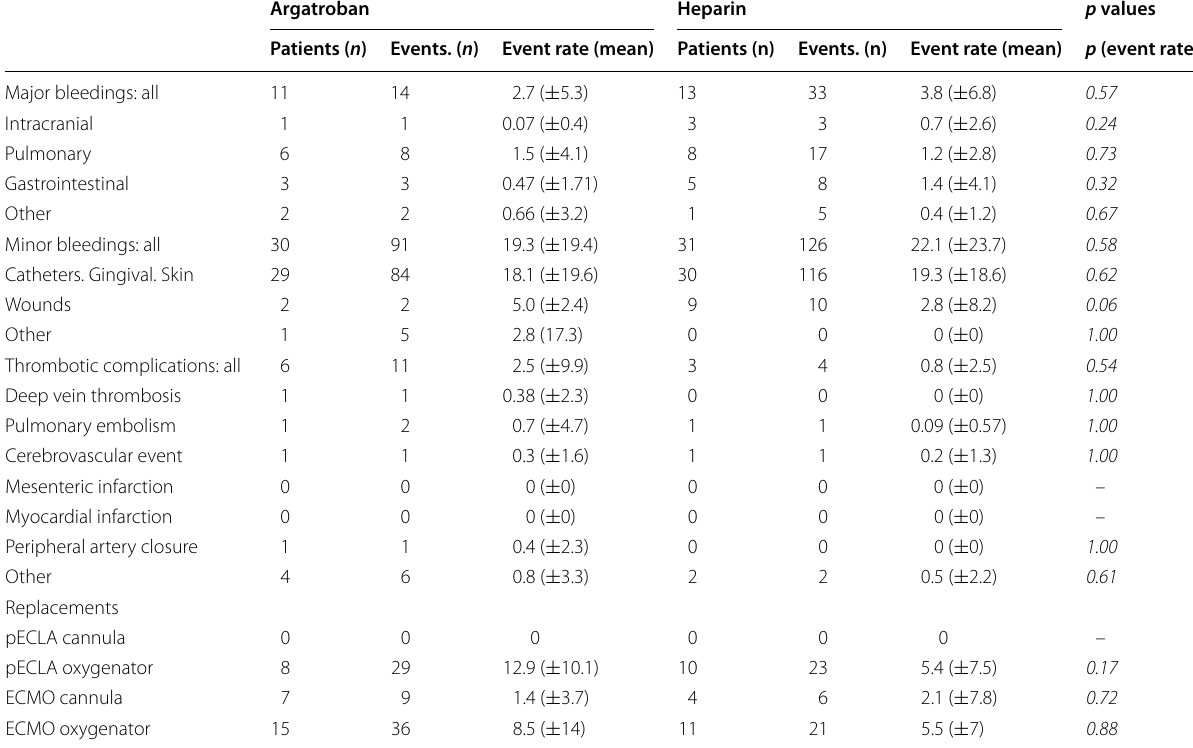
Table 2 Bleeding, thrombotic complications and replacements of extracorporeal lung support devices of ARDS patients on ECMO/pECLA with either argatroban or heparin